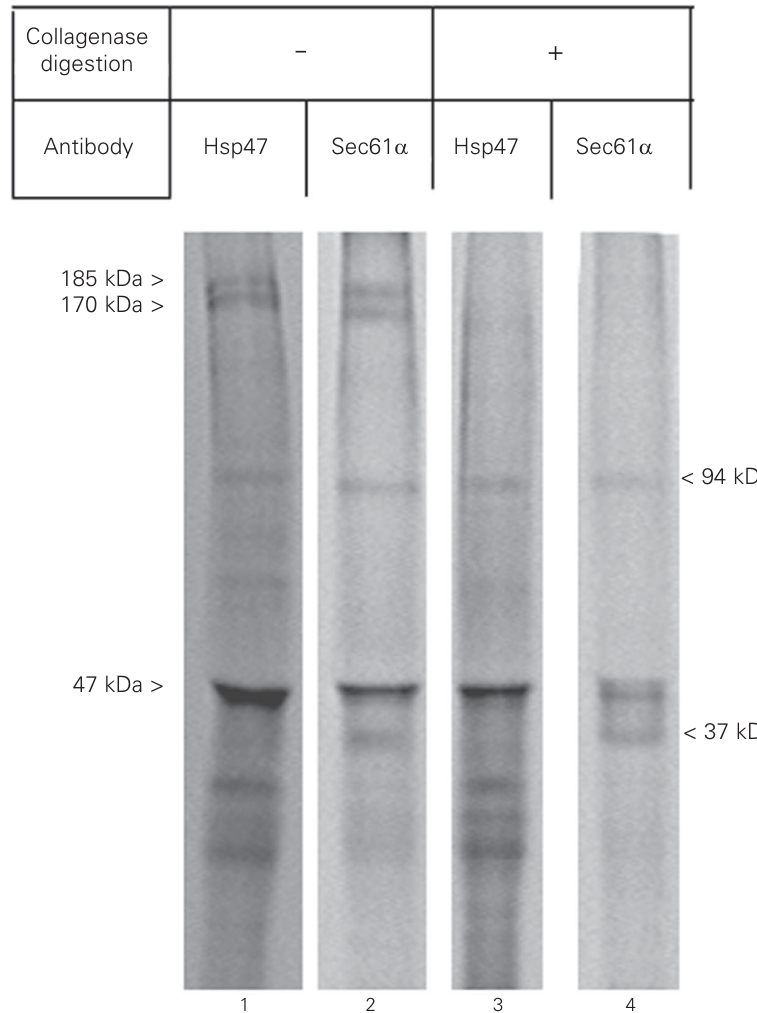
Figure 2. Immunoprecipitation with anti-Hsp47 and anti-Sec61 (cid:1) antibodies and collagenase digestion of retinoic acid-treated membrane-bound collagen IV microsomes following treat- ment with DSP. Microsomes were immunoprecipitated with anti-Hsp47 (lanes 1 and 3) and anti-Sec61 (cid:1) (lanes 2 and 4) antibodies. Collagenase digestion completely disrupted collagen microsomes (lanes 3 and